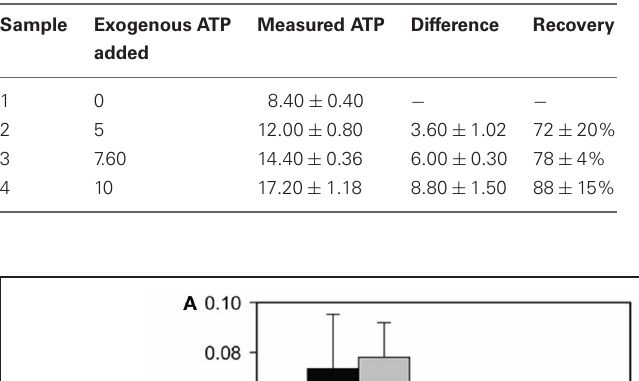
Table 1 | Metabolite recovery after extraction in boiling ethanol coupled with 60% methanol quenching.